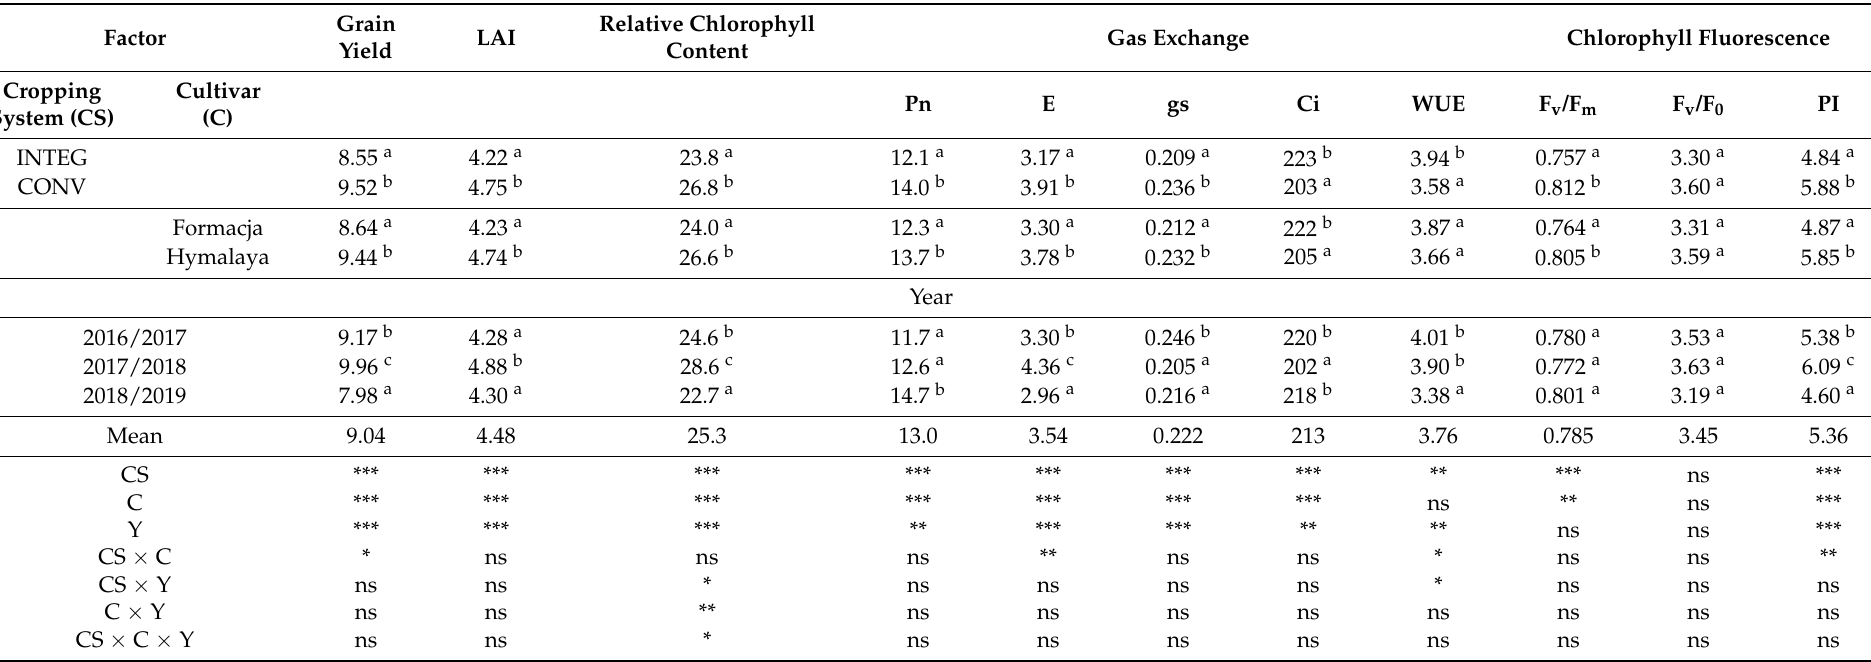
Table 3. Grain yield and selected physiological parameters depending on cultivars and cropping systems. The presence of different lowercase letters indicates a statistical difference between means (Tukey’s Test, p = 0.05). ***, **, * and ‘ns’ indicate significant difference, p < 0.001, p < 0.01 and p < 0.05 and non-significant differences, respectively. INTEG—integrated cropping system, CONV—conventional cropping